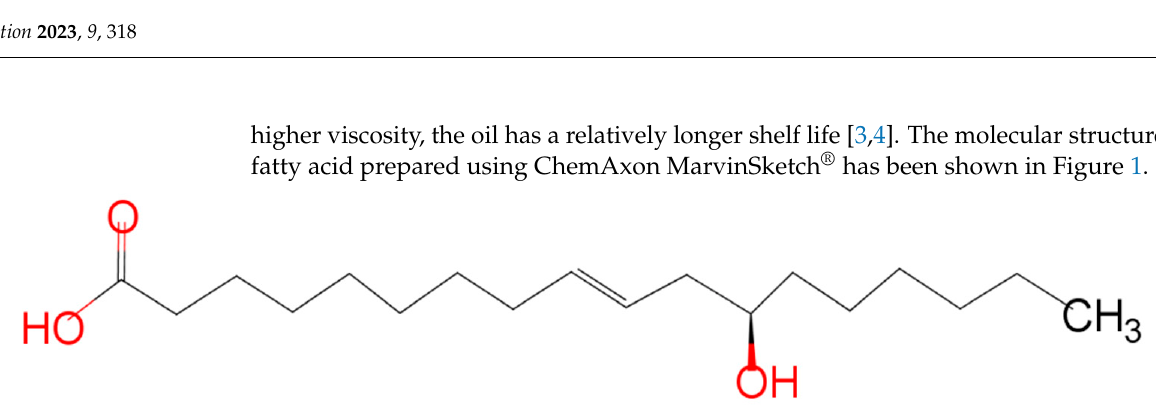
Figure 1. Chemical structure of Ricinoleic Acid.